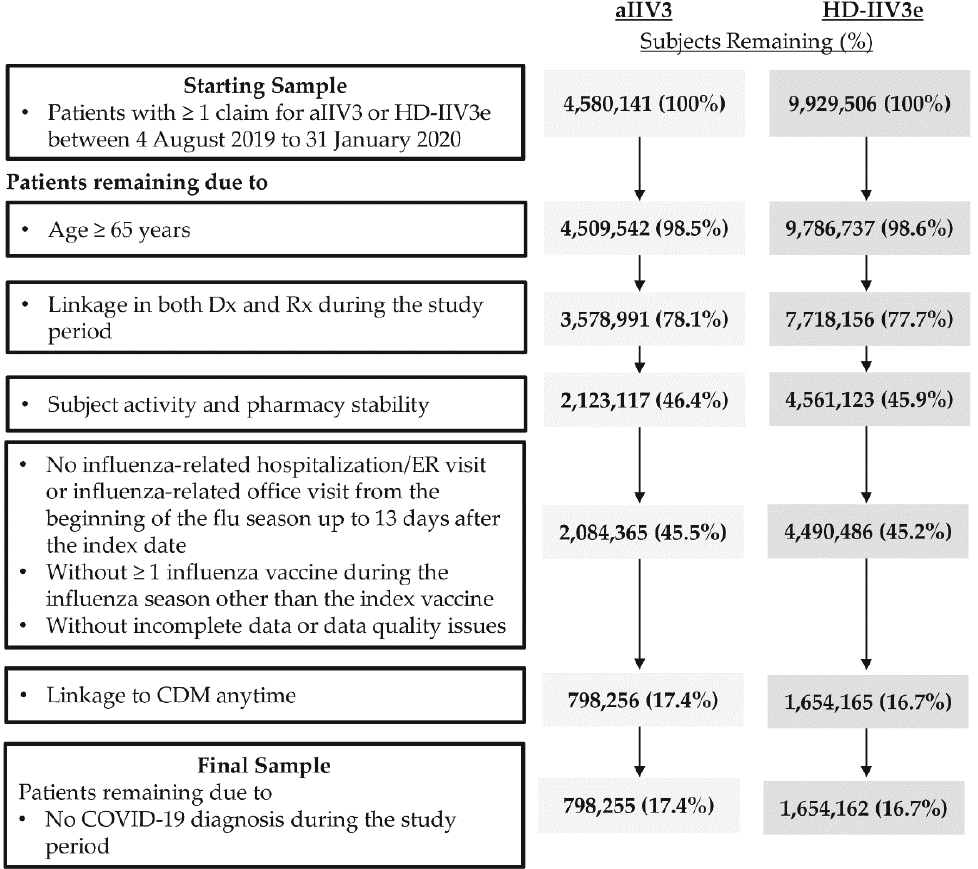
Figure 1. Patient Selection. Abbreviations. aIIV3 = adjuvanted trivalent influenza vaccine; CDM = Hospital Charge Data Master; COVID-19 = coronavirus disease 2019; Dx = Professional fee claims; ER = Emergency room; HD-IIV3e = high-dose trivalent influenza vaccine; Rx = Prescription claims.